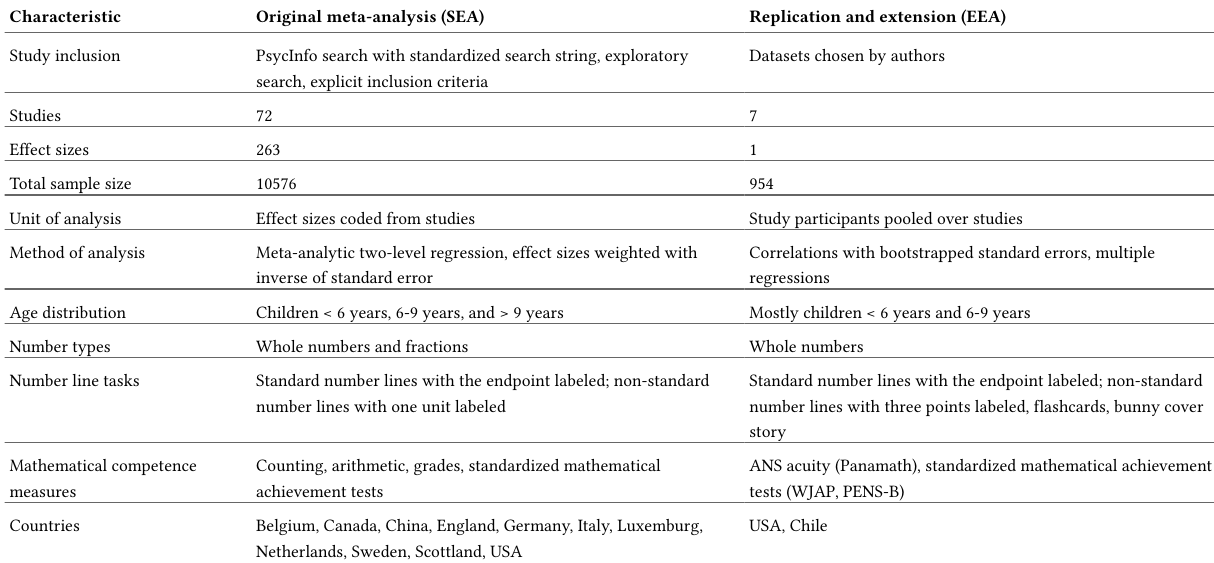
Differences Between the Original Meta-Analysis (SEA; Schneider et al., 2018) and the Replication (EEA, Ellis et al., 2021, this issue). Characteristic Original meta-analysis